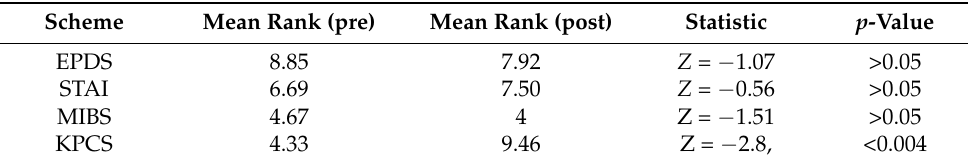
Table 2. Pre-post comparison for measures of